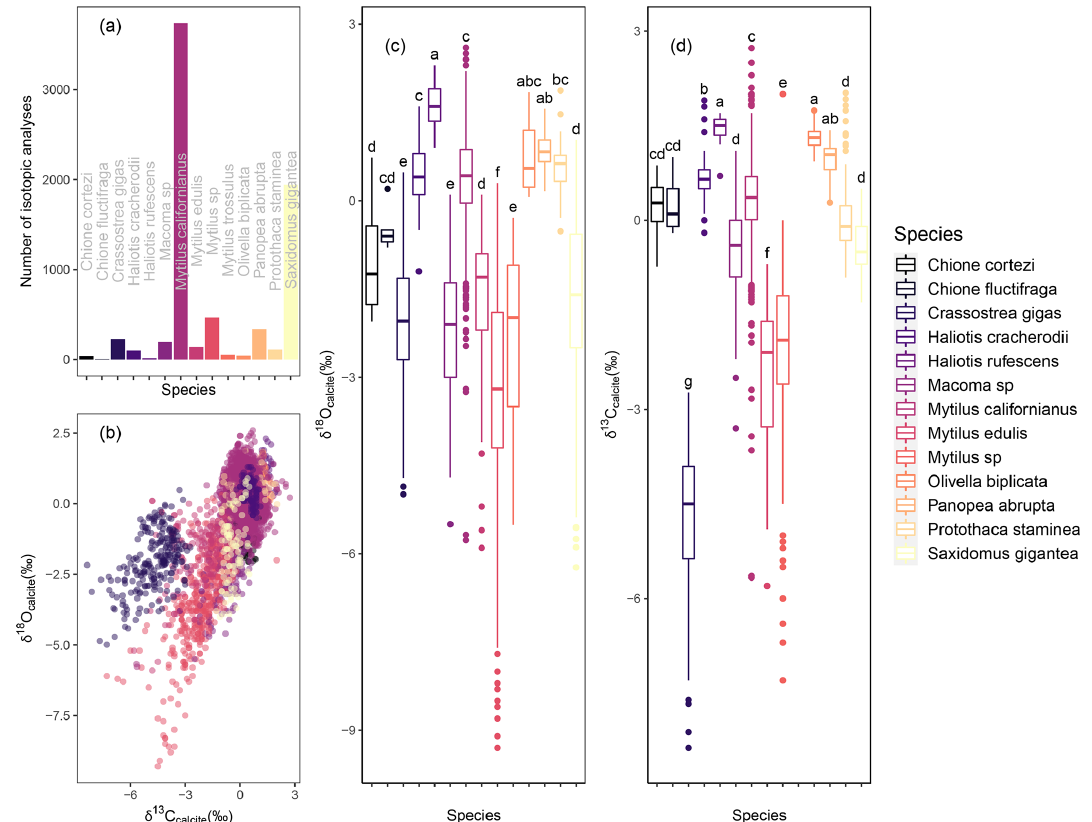
Figure 3. Taxonomic distribution of data. Histogram of number of entries in the database by taxonomic group. (a) Carbon vs. oxygen isotope values (‰ VPDB) colored by taxonomic group (b) . Box plot showing oxygen (c) and carbon (d) isotope values by taxonomic group. Letters in panels (c) and (d) indicate which taxa are statistically similar in terms of oxygen and carbon isotope values, respectively (Tukey, p > 0 .